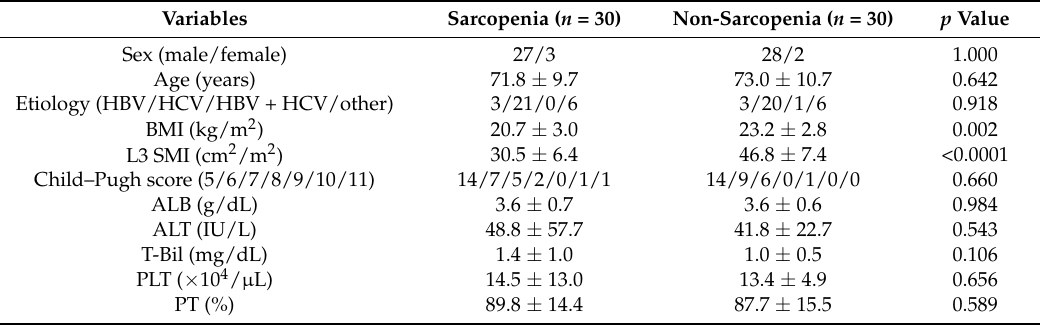
Table 3. Baseline demographic and clinical characteristics of sarcopenia and non-sarcopenia groups after adjustments for possible confounding factors using propensity score matching